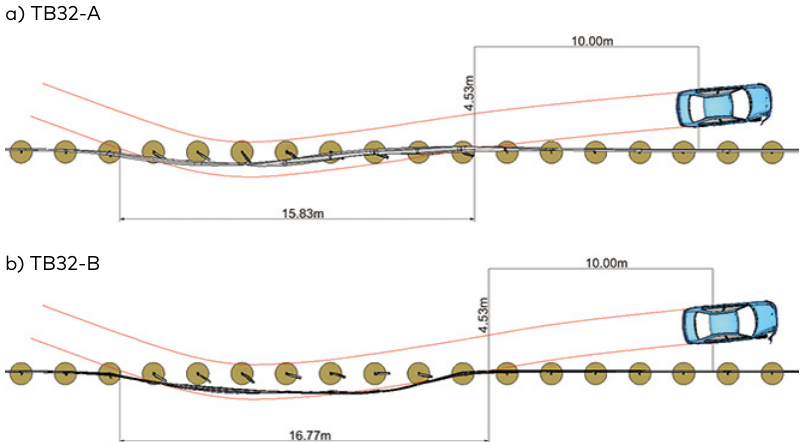
Figure 16. Vehicle repulse after collision with barrier, and length of vehicle contact with barrier (view from